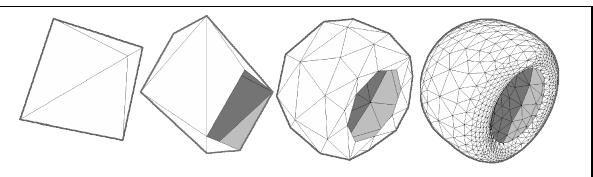
Figure 1. Mesh generation of a parametric model of a